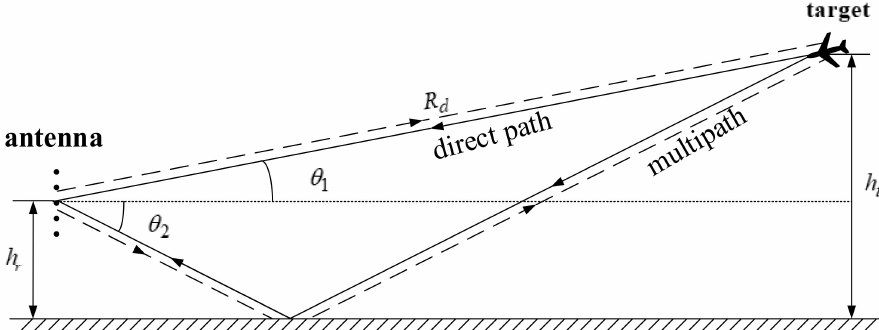
Figure 1. Geometry for the low-angle estimation scenario in MIMO